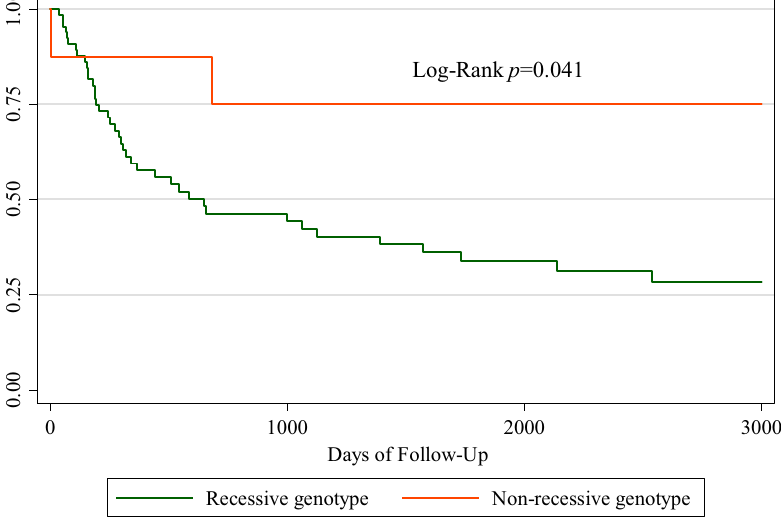
Figure 3. Kaplan–Meier survival plot of the recessive genotype of rs6761893 located in EFEMP1